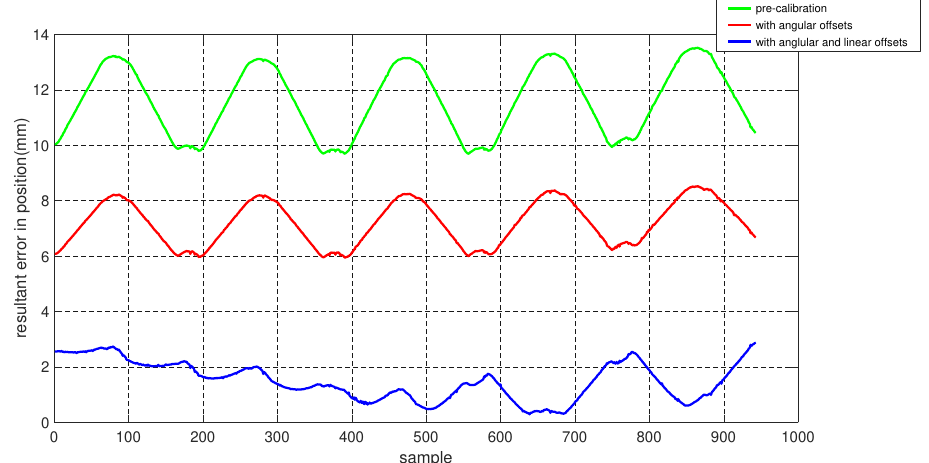
Figure 15. Resultant end-effector position error for the training set before and after calibration.